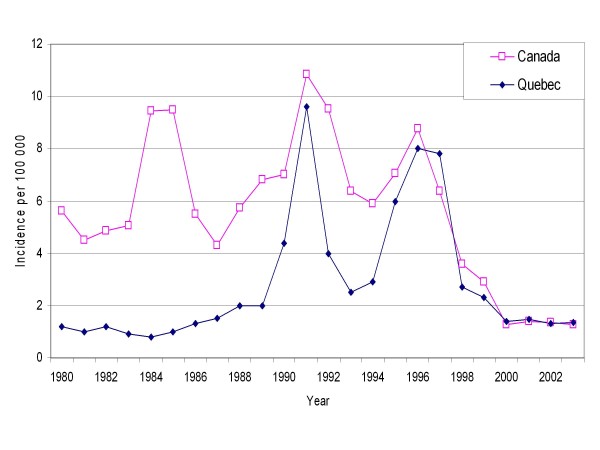
Reported Incidence per 100 000 Between 1980 and 2003 in Quebec and Canada.